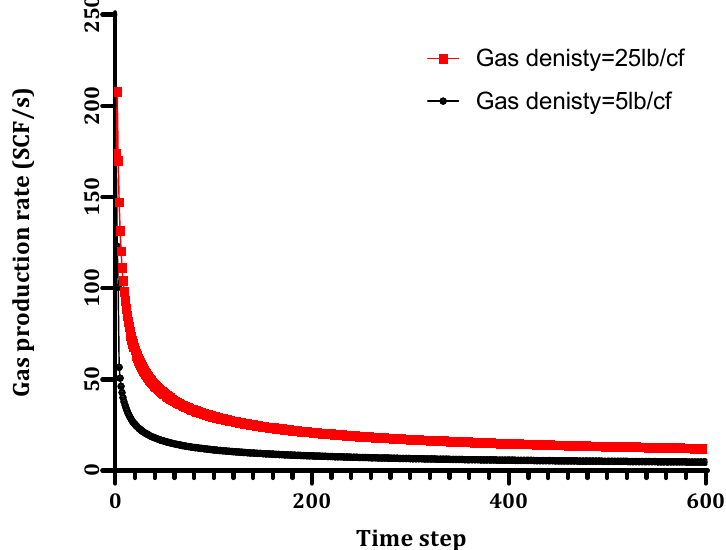
Figure 12. Comparison between production profiles for different gas densities.